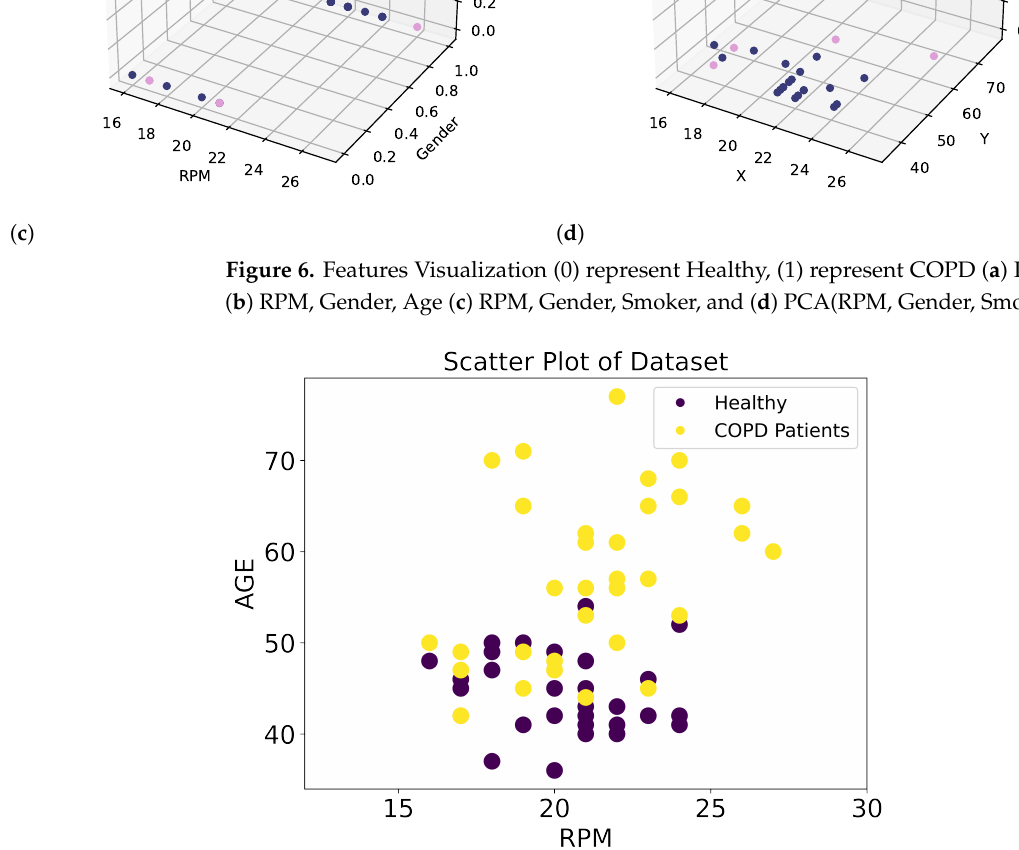
Figure 7. RPM distribution for healthy persons and COPD patients concerning